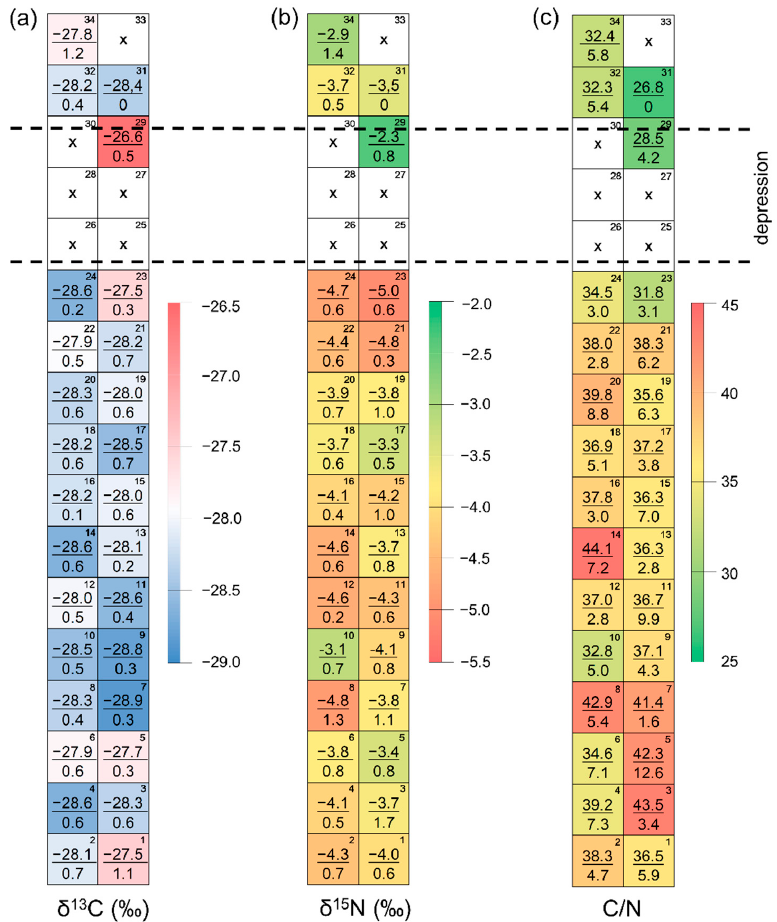
Figure 4. Spatial variations in ( a ) the foliar δ 13 C (‰), ( b ) the foliar δ 15 N (‰), and ( c ) the foliar C/N ratio averaged in each plot (average and standard deviation values are shown as numerator and denominator, respectively). Variations are presented as the heat maps with color scale bars. Serial numbers of the plots are shown at the top right corners. Number of samples from the plots was n = 1 for the RF-1 plot No. 31, n = 2 for the RF-1 plots No. 23 and 24, n = 4 for all other plots (results from No. 25 to 28, 30, and 33 are not shown because mature trees were not available). Black dash lines display the conditional borders of the depression in the transect (plots from No. 25 to 30).